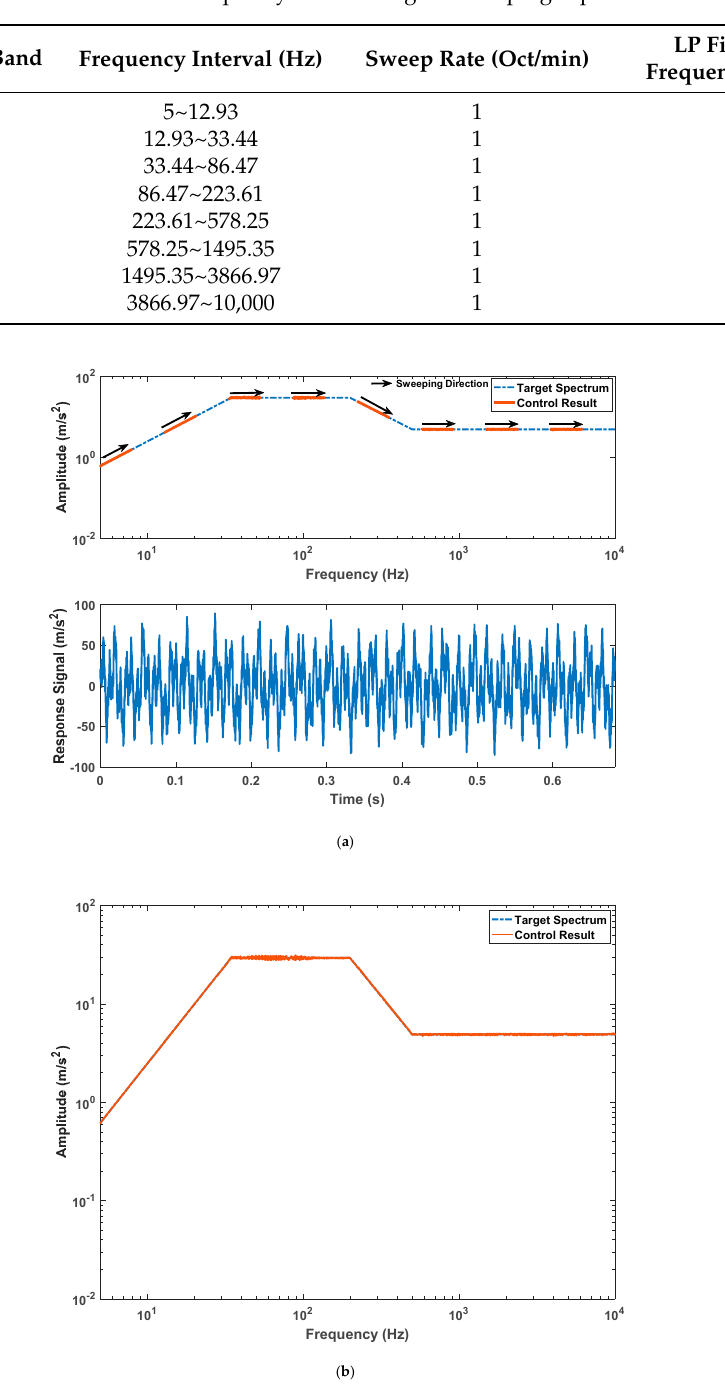
Figure 7. The results of sweeping experiments: ( a ) the instantaneous spectrum trajectory and time-domain curve; ( b ) the spectrum of the sweeping experiment